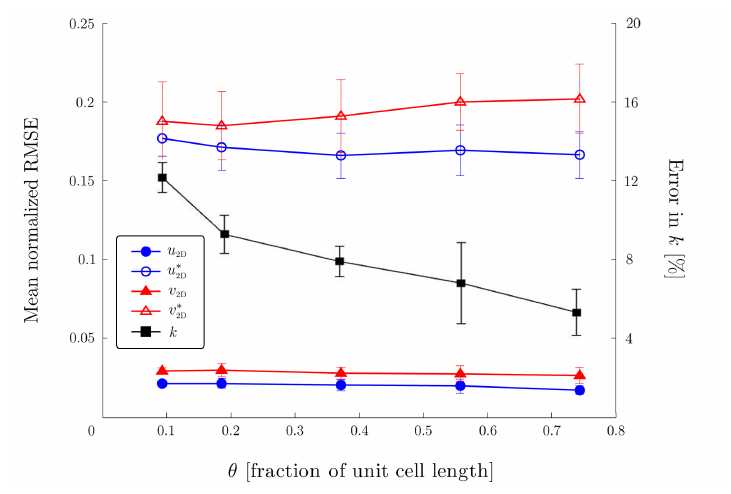
( x, y ) and u ∗ ( x, y ) (left vertical axis) and error Figure 5. Mean normalized RMSE for u 2D 2D in computed permeability (right vertical axis) versus θ , the aperture covariance range. The mean value and standard deviation, shown with bars, are calculated over 15 realizations of h ( x, y ) at each θ . Note that permeability is consistently overpredicted, i.e. , percent error is